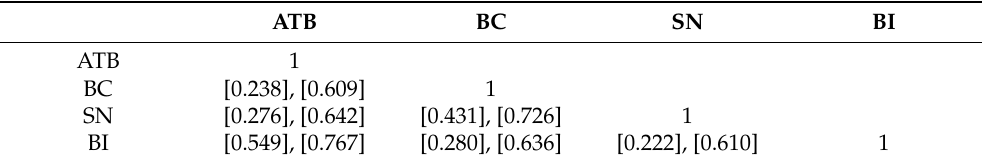
Table 6. Confidence Intervals